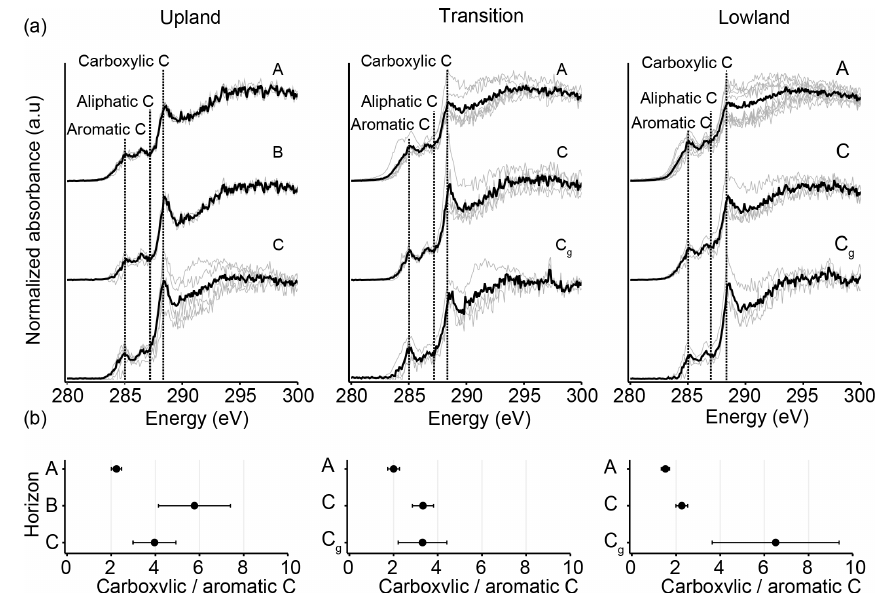
Figure 5. C (1s) NEXAFS analyses of solid-phase OM chemistry across upland–lowland transects. (a) NEXAFS spectra from six replicate wetlands (grey), plotted for each landscape position and depth, with the resulting mean spectra plotted (black). Peaks of particular interest are carboxylic C (285.35eV), aliphatic C (287.20eV), and aromatic C (285.03eV) denoted by dotted vertical lines. (b) Average carboxylic-to- aromatic C (285.35eV/285.03eV) ratios plotted for each landscape position and depth; bars are standard error of the mean of the replicates.